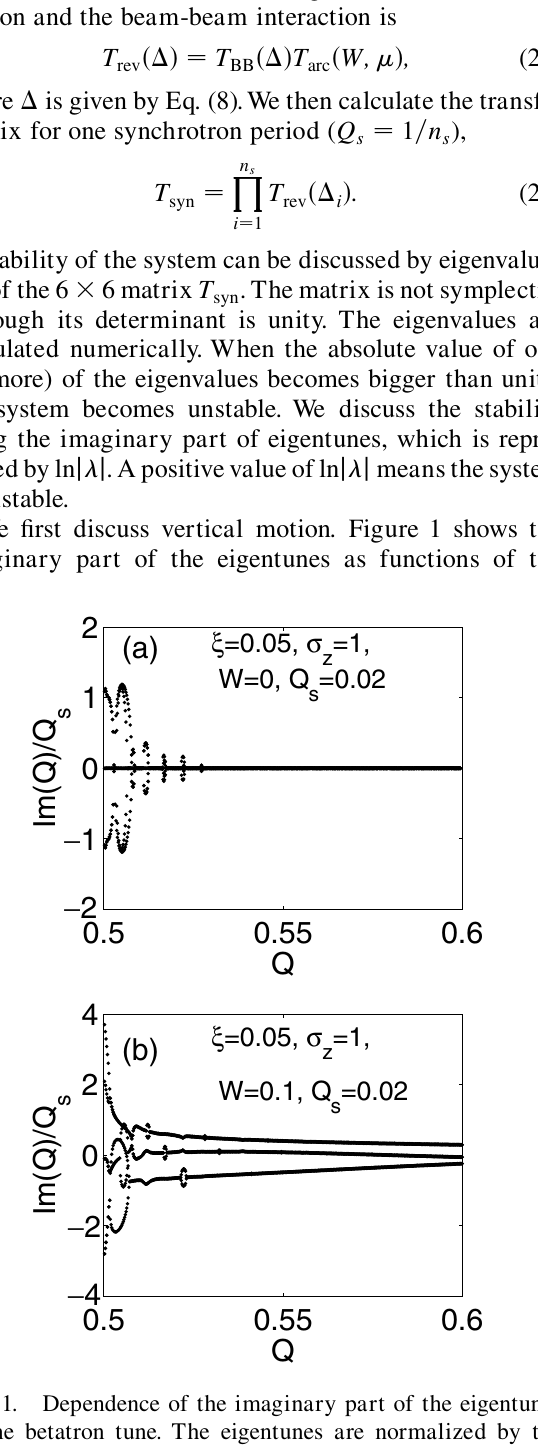
FIG. 2. Dependence on the wake strength at (cid:23) (cid:4) 0 : 05 (a) and the beam-beam parameter at W (cid:4) 0 : 1